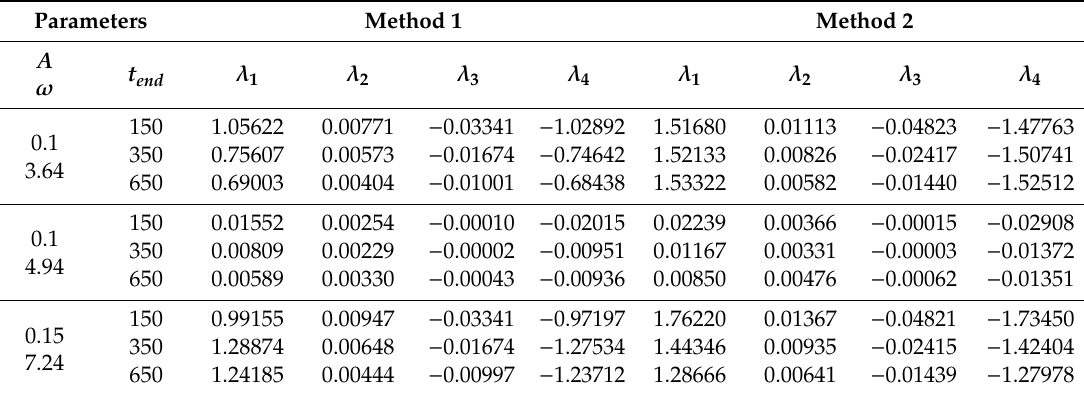
Table 4. Spectra of Lyapunov exponents for the first mutation of rigid pendulum.